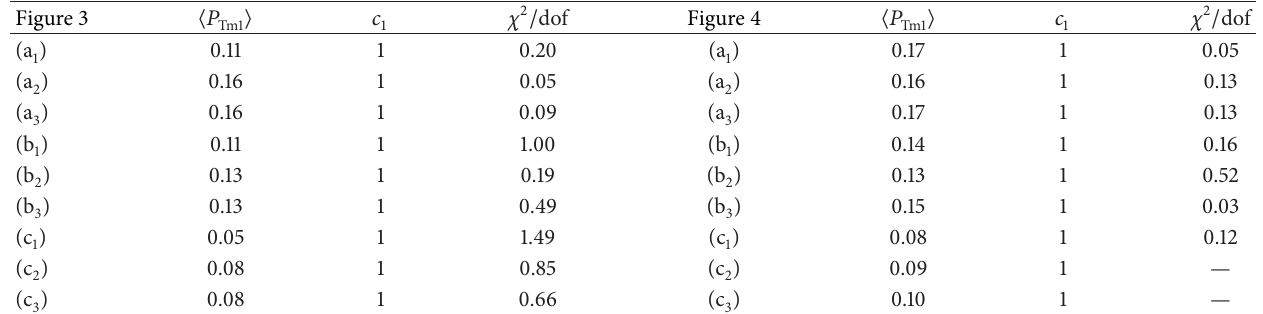
Table 2: Values of ⟨𝑃